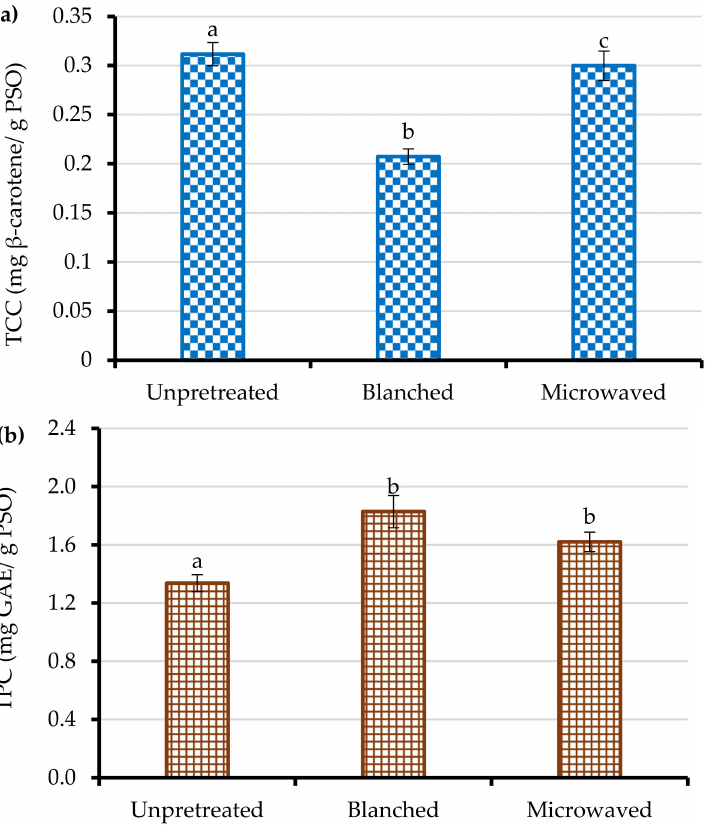
Figure 2. ( a ) Total carotenoids content (TCC) and ( b ) total phenolic content (TPC) of cold-pressed pomegranate seed oil (PSO) from unpretreated, blanched (95 ± 2 ◦ C/3 min), and microwave-heated (261 W for 102 s) seeds. Columns followed by different letters are significantly different ( p < 0.05) according to Duncan’s multiple range test. Vertical bars indicate the standard deviation of the